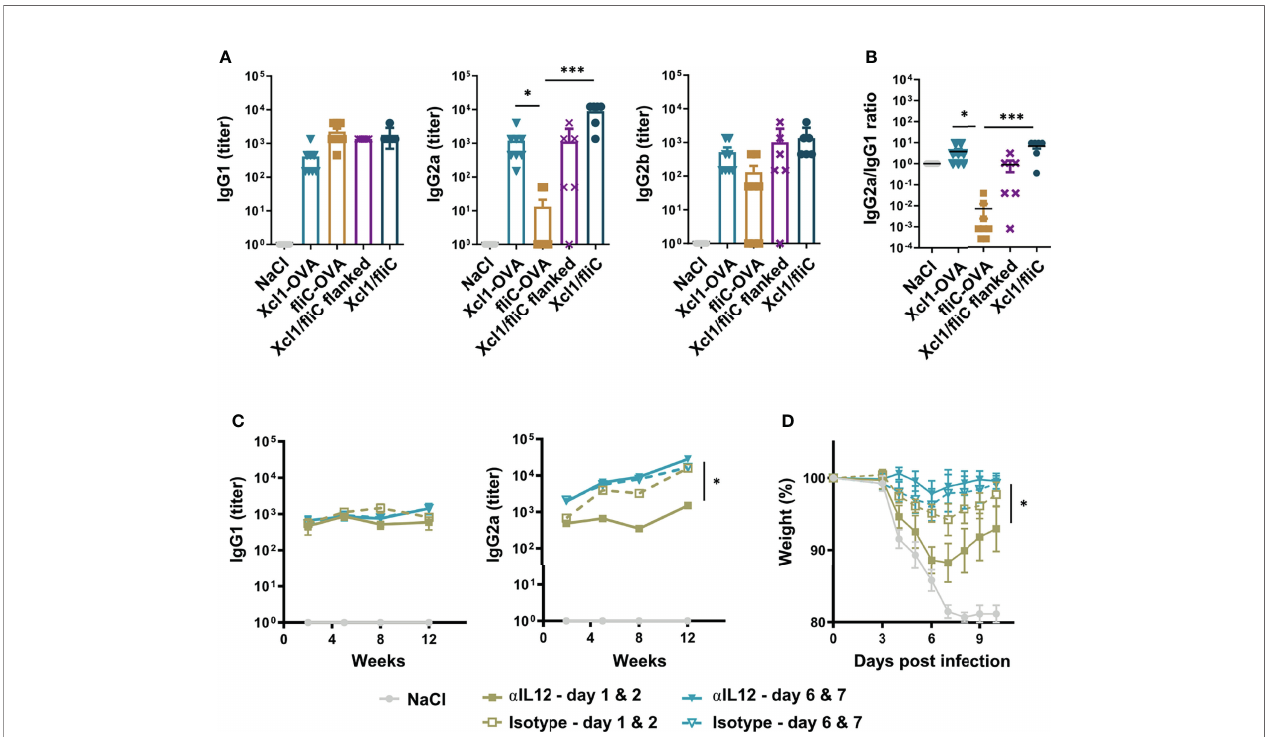
FIGURE 5 | Rapid Th1 induction is essential for induction of an IgG2a dominated response and improves protection induced by a mixed fl iC-/Xcl1-HA vaccine. (A, B) DNA immunization of BALB/c mice with 25 m g DNA encoding Xcl1-HA, fl iC-HA, a mixture of Xcl1-HA and fl iC-HA, or Xcl1-HA and fl iC-HA delivered on opposite fl anks. (A) Serum titers of IgG1, IgG2a, and IgG2b were determined 2 weeks after vaccination. (B) IgG2a/IgG1 ratio of the serum samples presented in (A) . (C, D) Injection of either anti-IL-12 or isotype-matched mAbs on days 1 and 2 or 6 and 7 after DNA immunization with a mix of Xcl1-HA and fl iC-HA plasmids. (C) Serum samples were harvested at the indicated time points and evaluated for the presence of HA-speci fi c IgG1 or IgG2a. (D) Mice in (C) were challenged with 5xLD50 PR8 virus 12 weeks after immunization and weight loss monitored. Data representative of one experiment with n = 6 – 8 mice per group (A, B) , representative of two independent experiments with n = 4 mice per group (C) or pooled from two independent experiments with n = 8 mice per group (D) . Statistical analysis performed by non-parametric one-way ANOVA with Dunn ’ s multiple-comparison corrections (A, B) , or two-way ANOVA with Tukey ’ s multiple-comparison test (C, D) . *p < 0.05, ***p <